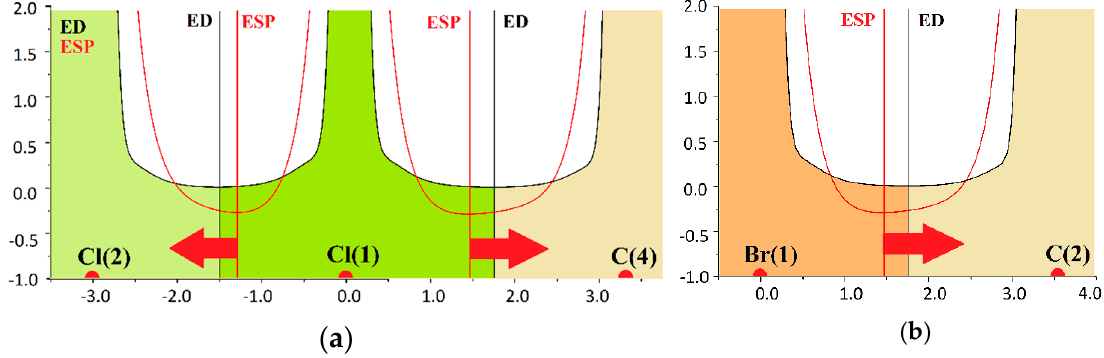
Figure 5. The disposition of electron density and electrostatic potential minima (a.u.) ( a ) along two interatomic lines Cl(2) ··· Cl(1) − ··· C(4), (Å), in LONGEB; ( b ) along the tetrel bond in LILLOH. The arrows point to the electrophilic site provider .